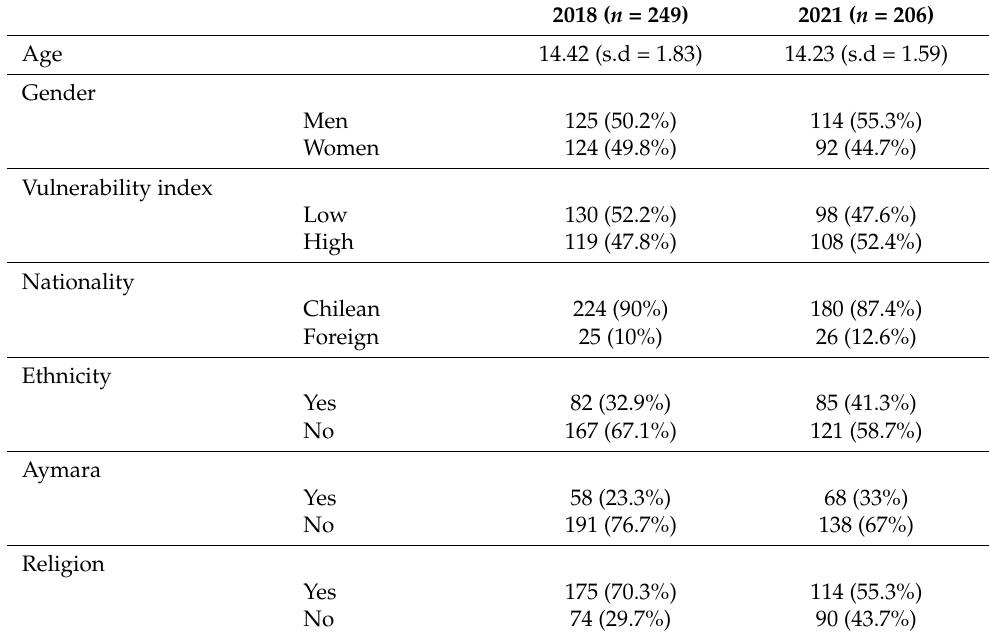
Table 1. Sociodemographic characteristics of the